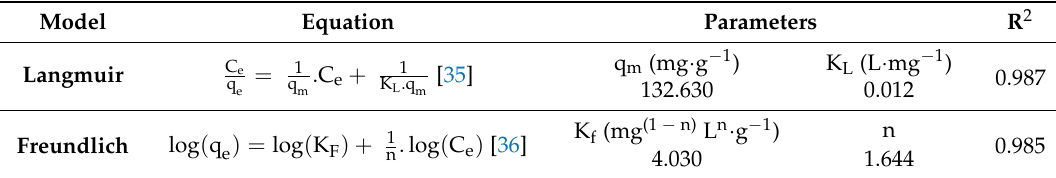
Table 4. Isotherm parameters of ARS adsorption.